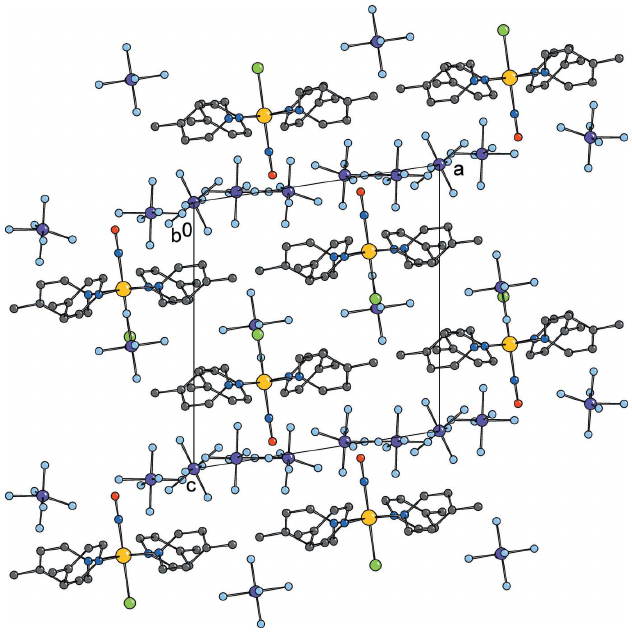
Figure 2 Crystal packing of trans -[Ru(C 6 H 7 N) 4 Cl(NO)](PF 6 ) 2 (cid:2) 0.75(CH 3 ) 2 CO viewed along the b axis, showing cationic rows. Hydrogen atoms and solvent molecules are omitted for clarity.